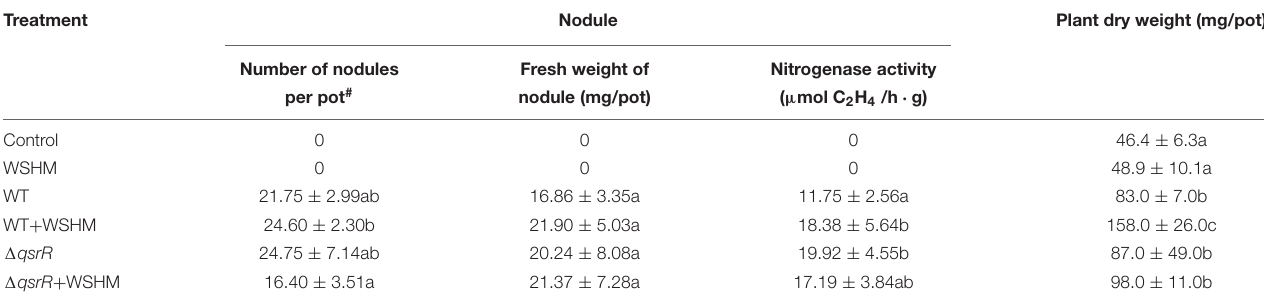
TABLE 1 | Effects of WSHM on nodulation of M. sativa inoculated with S. meliloti (cid:49) qsrR or S. meliloti 8530 (WT) in the greenhouse ∗ .